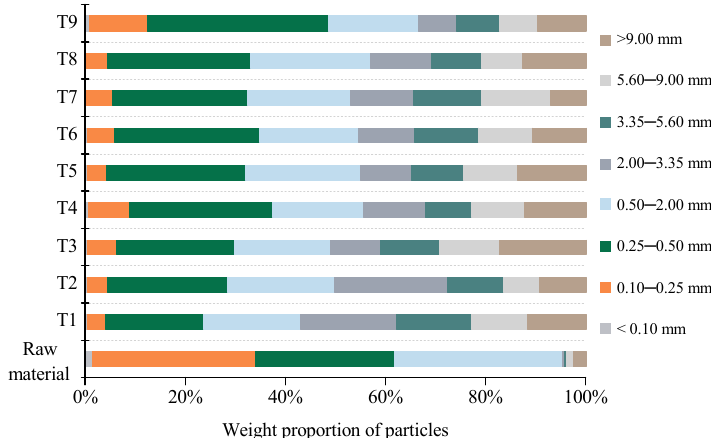
Figure 5. Variation in particle size distribution of the initial CB and final products (Raw material: initial CB, Treatments T1–T9 are described in Table 1).